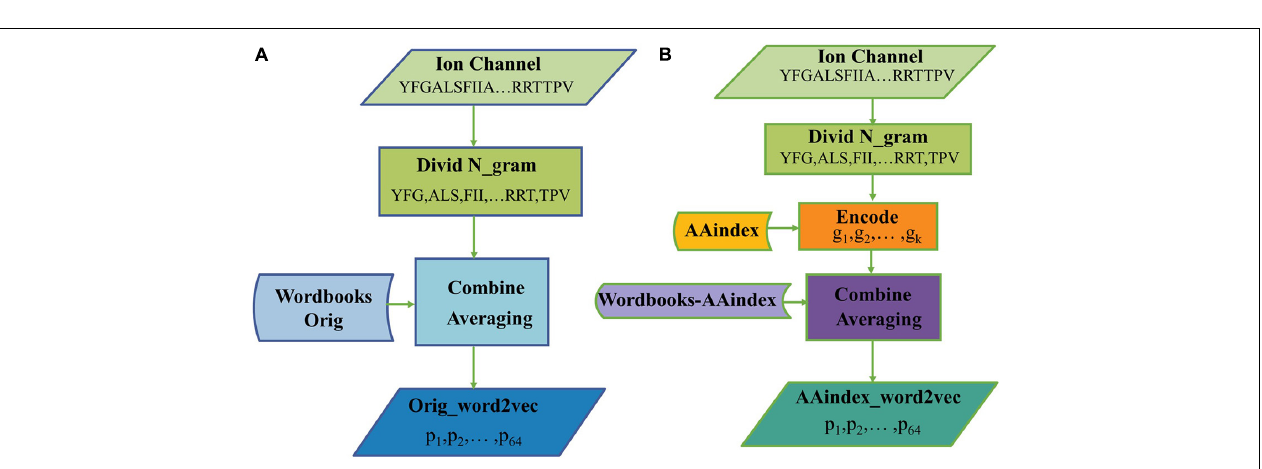
FIGURE 2 | The processes of generating protein representation through (A) Orig_word2vec and (B) AAindex_word2vec.